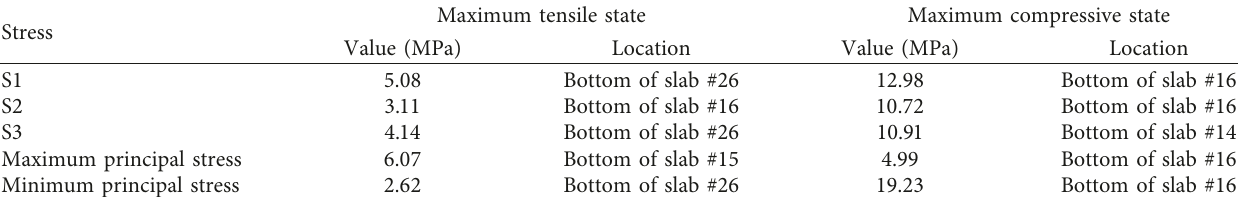
Figure 18: Stress distributions of face slabs (Pa): (a) maximum principal stress; (b) minimum principal stress. Table 5: Maximum tensile and compressive stress of face